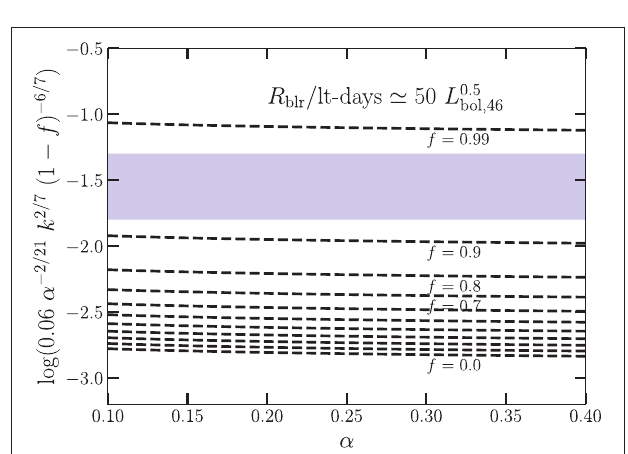
FIGURE 3 | The logarithm of the normalization of Equation (2) as a function of the accretion disc viscosity, α . The factor κ is fixed to 1.3 corresponds to a broad line region size of about 1.3 days) and L bol 10 46 erg s − 1 . The dashed black lines represent different = values of f in the range from 0 to 0.99. The blue shaded area indicates the observed range of the normalization of the L X sample of 500 quasars. Figure based on data derived from Lusso and ∼ Risaliti